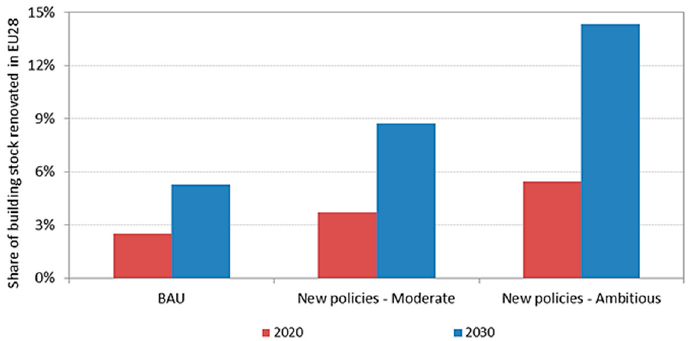
Figure 4. Share of EU 28 building stock renovated deeply (or to an NZEBs level) by 2020 and 2030, varying the policy scenario. Source: elaboration from Entranze [20].